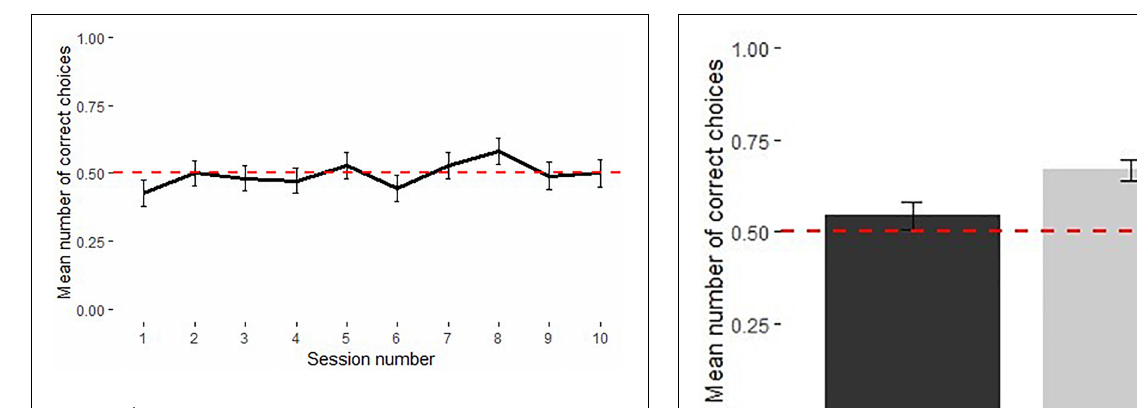
FIGURE 8 | Performance of chimpanzees in shaken boxes across sessions in Experiment 4 ( N = 11). Dotted line shows chance level performance ( p = 0.05), error bars represent SE .